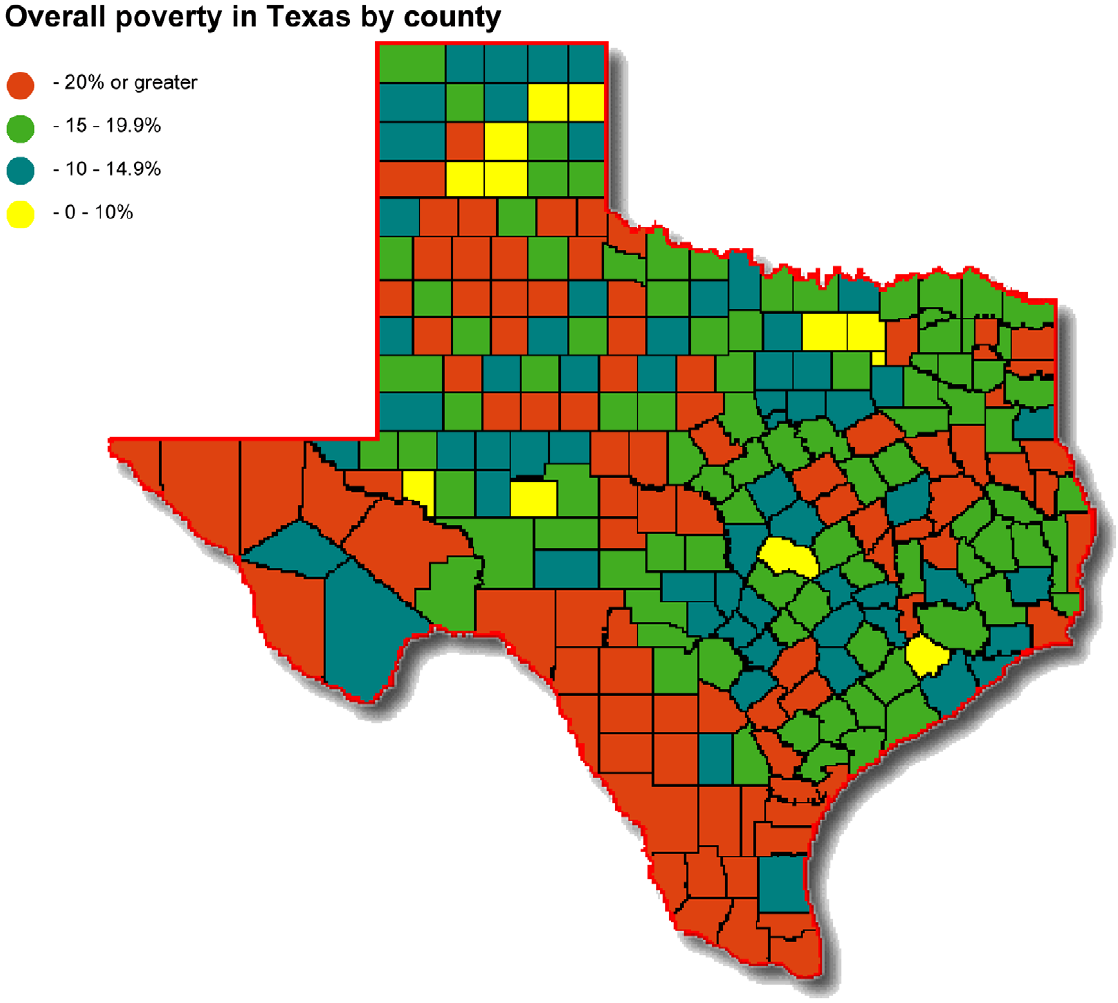
Figure 2. Figure created at diy.net with data from US Census Bureau 2010 Small Area Income and Poverty Estimates accessed at http://www.census. gov/did/www/saipe/county.html March 6,